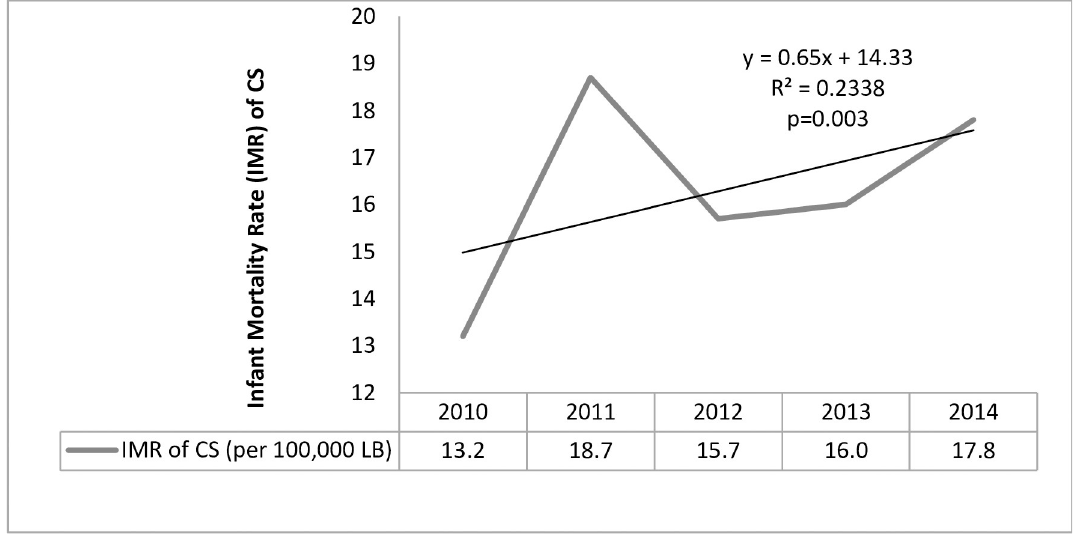
Fig 3. Infant Mortality rate of congenital syphilis after linkage. Ceara´, Brazil, 2010–2014.